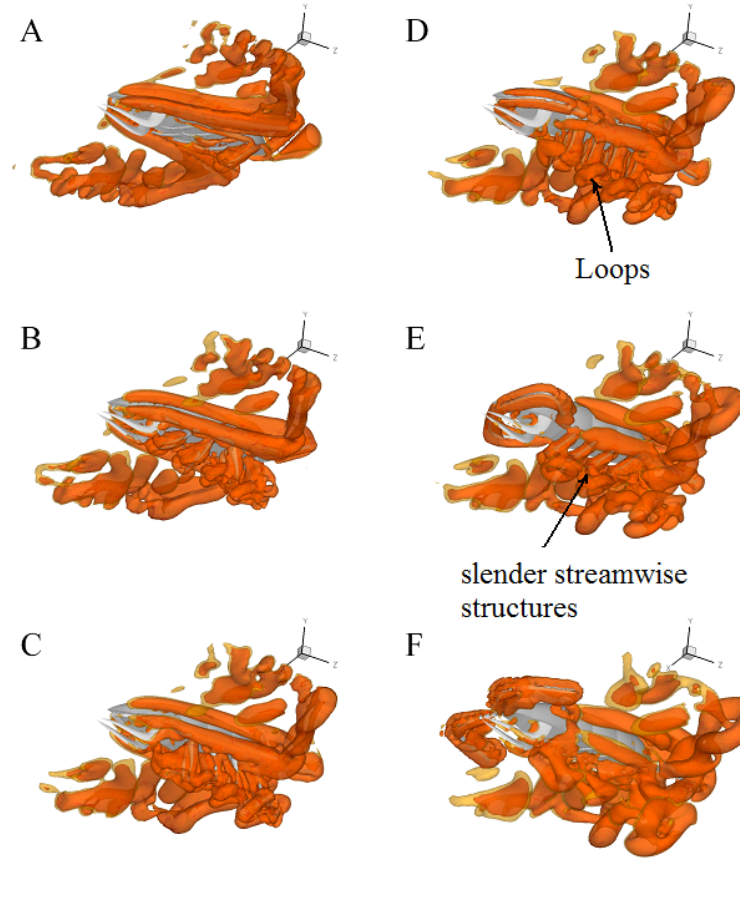
Figure 3. Vortical structures visualized by the iso-surfaces of q-criterion around the tethered copepod with deformable antennae ( Re = 300, T = 0.3) at different time instance ( A ) t/T = 0.28 the first stoke of legs begins by the last pair ( B ) t/T = 0.36 the middle of legs power-strokes ( C ) t/T = 0.48 almost the end of the legs power-stroke ( D ) t/T = 0.56 the legs return-stroke has started ( E ) t/T = 0.66 towards the end of the legs return-stroke ( F ) t/T = 0.86 the legs return stroke has been ended for some time. Reproduced with permission from [4]. See Video S2 in supplementary materials for a movie of the wake